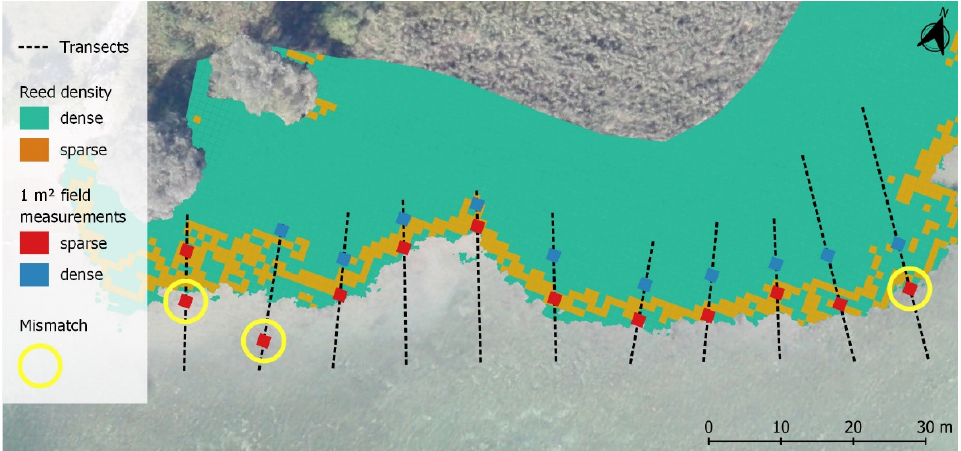
Figure 8. Modeled aquatic reed density at AOI6 and for comparison field measurements of reed density. Mismatches between modeled and measured data are represented by yellow circles. Table 3. Accuracy assessment showing the comparison between classified reed densities and refer- ence data measured in the field.